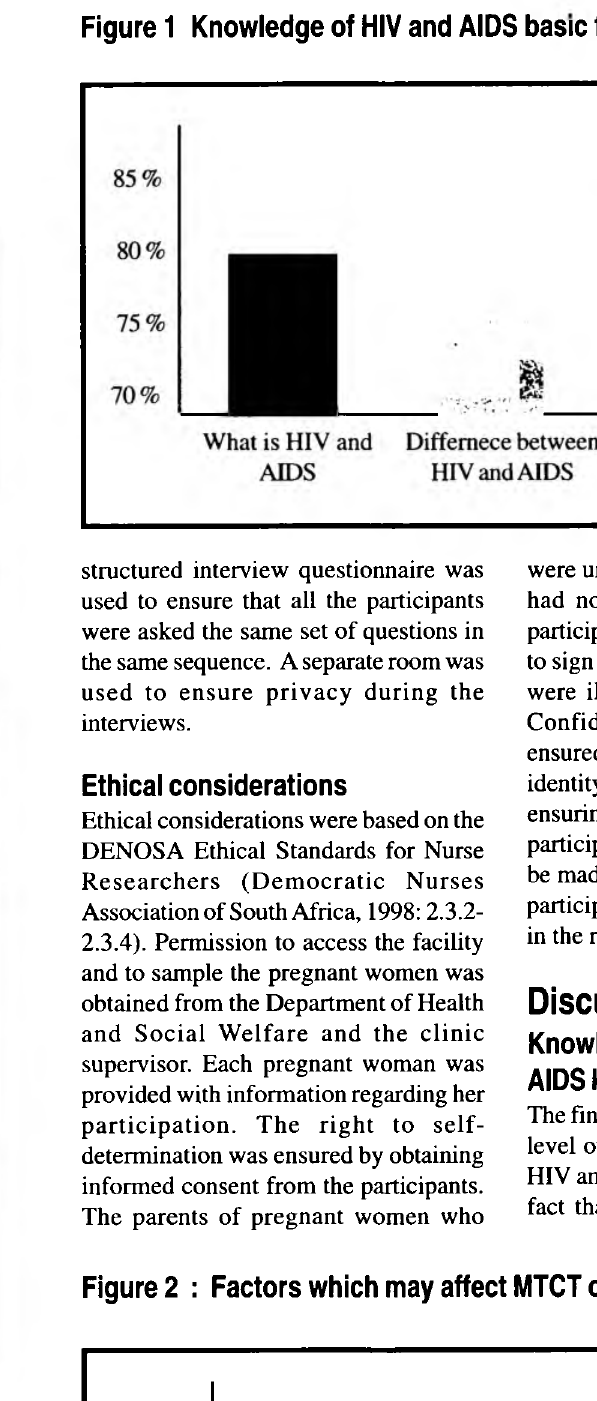
Figure 2 : Factors which may affect MTCT of HIV (adaptd from WHO, 2000:6) 100%